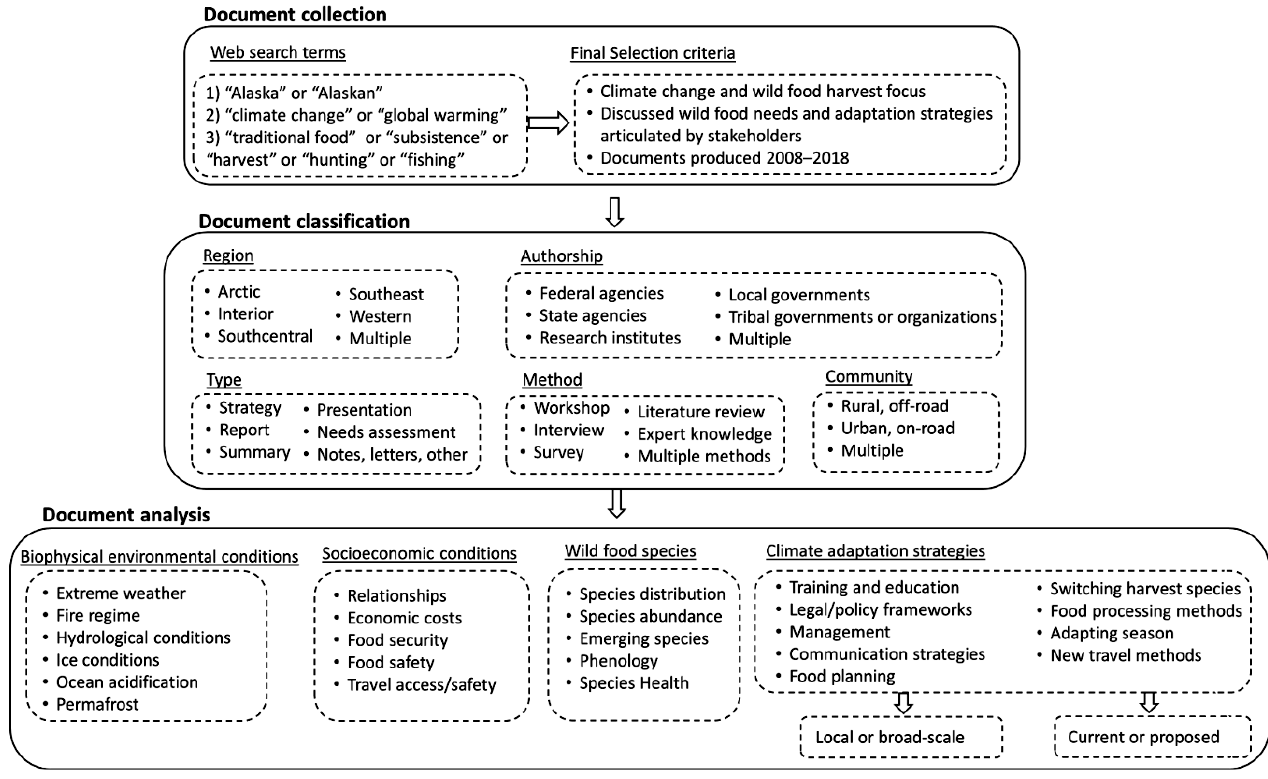
Fig. 1 . Graphical representation of the document coding and analysis